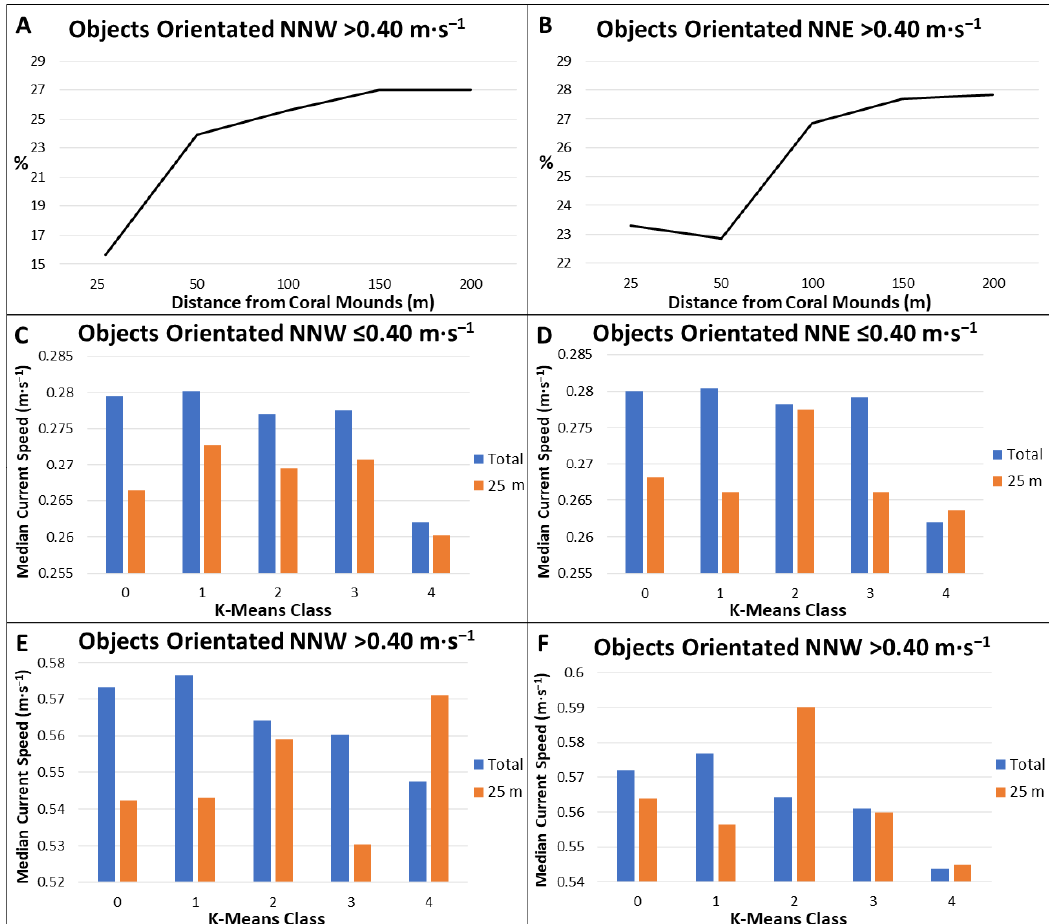
Figure 7. The proportion of FG “crests” over distance from the “mounds” for ( A ) north-north-west aligned “crests”, ( B ) north-north-east aligned “crests”, and a comparison of median current speeds for each class taken at ≤ 25 m from the “mounds” and the whole dataset for ( C ) all north-north-west aligned SG “crests” ( D ) north-north-east aligned SG “crests”, ( E ) north-north-west aligned FG “crests”, ( F ) north-north-east aligned FG “crests”.